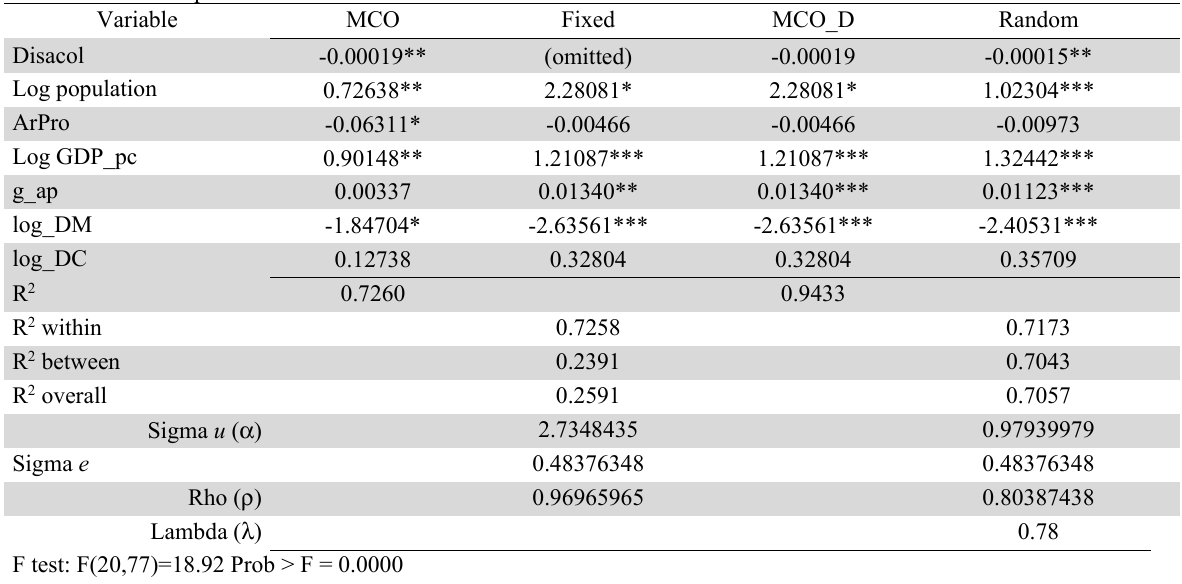
Panel models for